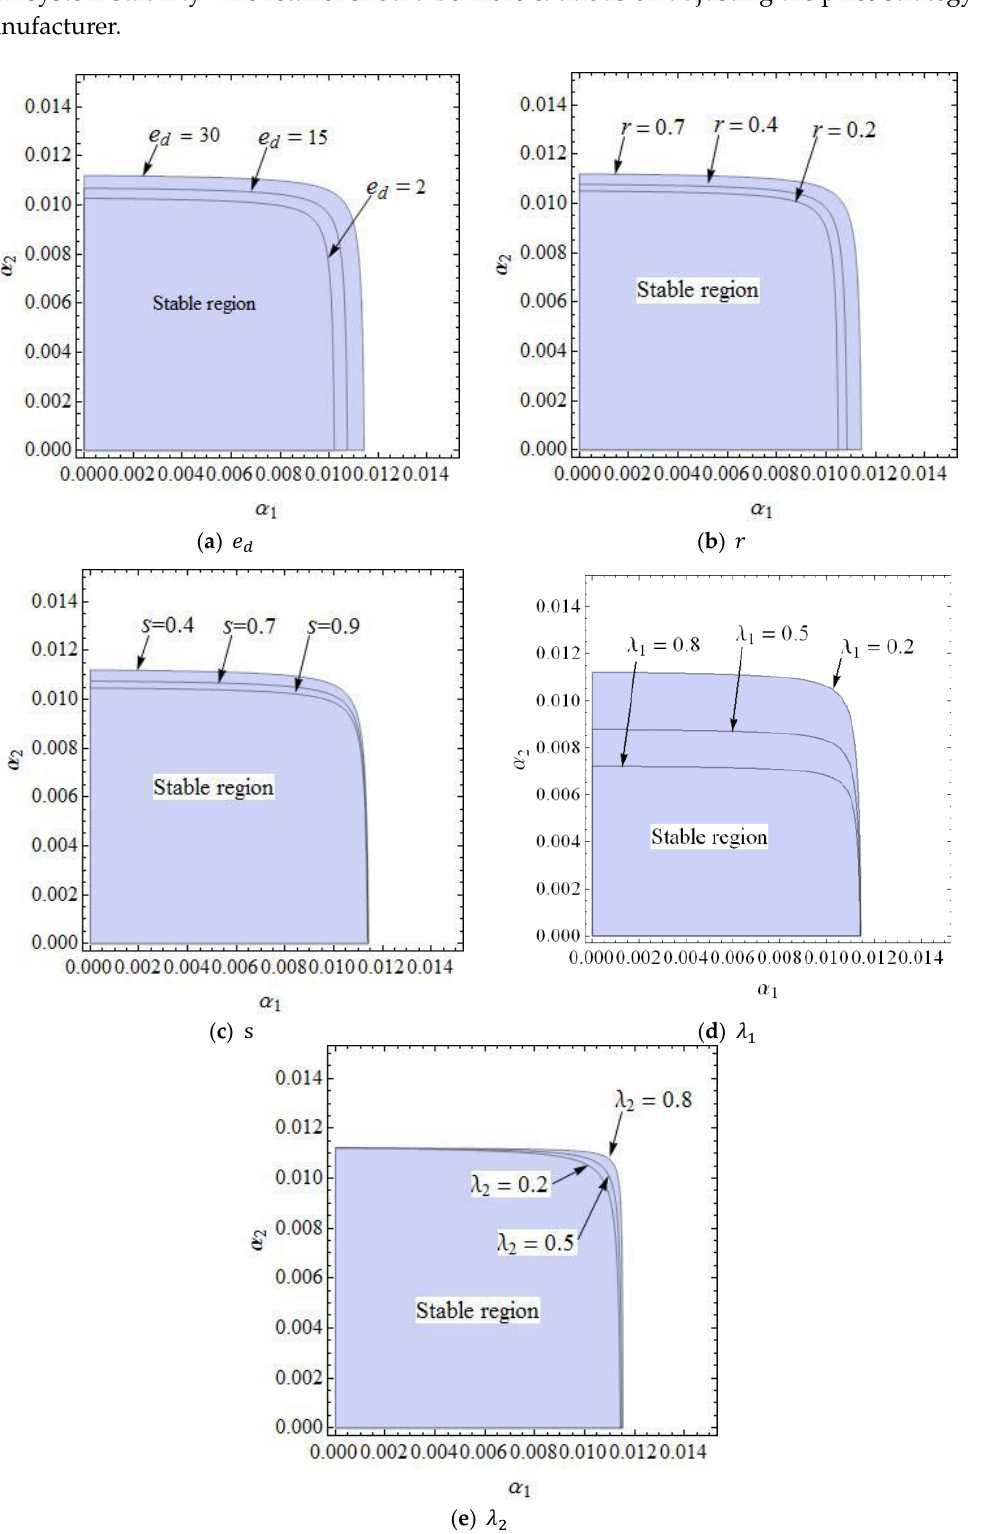
Figure 4. The parameter basins of 𝛼 1 and 𝛼 2 with different parameter values.